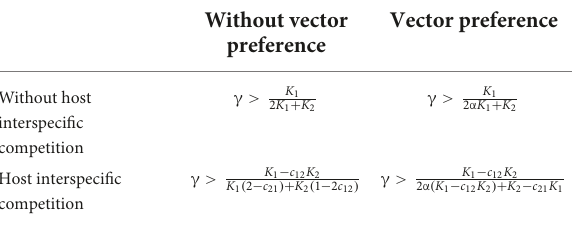
TABLE 2 The analytical conditions for the criterion of R 0 < R 1 0 in four different